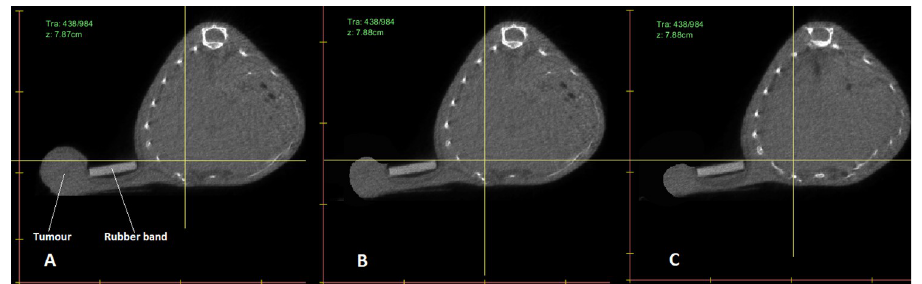
Fig 4. Mouse CT image set. Image A demonstrates the transversal view of a slice of the original mouse CT image set with the maximum xenographic tumour diameter of 1 cm. Images B and C demonstrate the modified tumours with diameters of 0.75 cm, and 0.5 cm, respectively. The xenographic tumour and the rubber band that distances the tumour from the mouse healthy tissue are marked in image